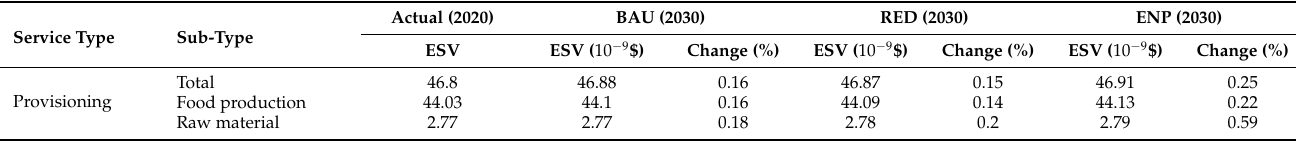
Table 10. Simulated scenarios of total ESV of